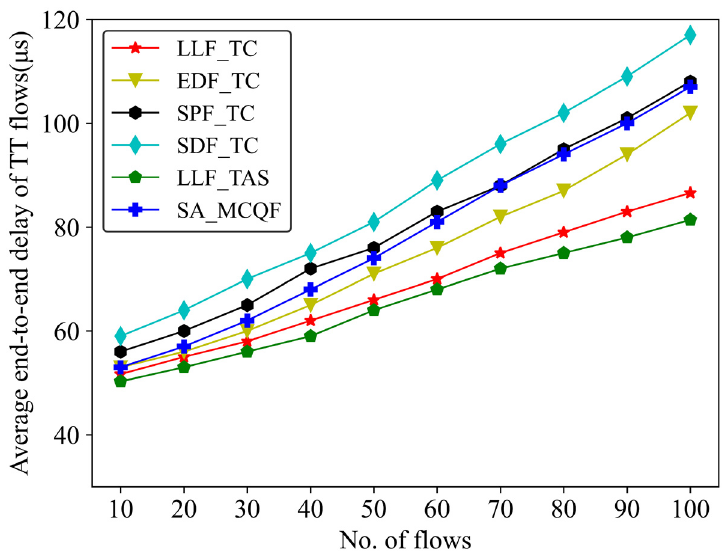
Figure 12. Average end-to-end delay of TT flows with different scheduling methods.